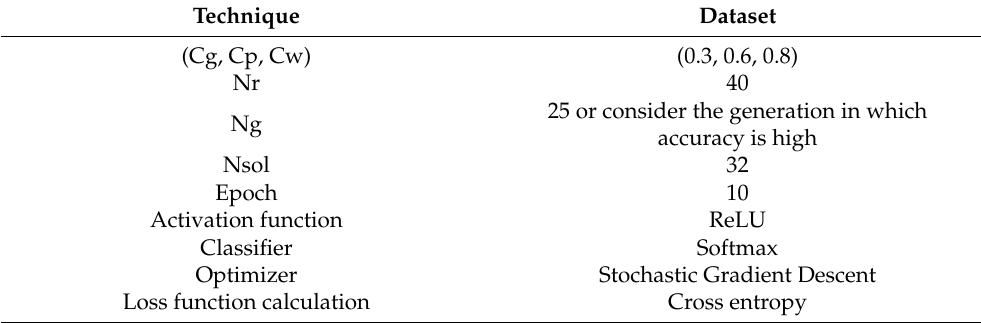
Table 10. Summary of Parameters.